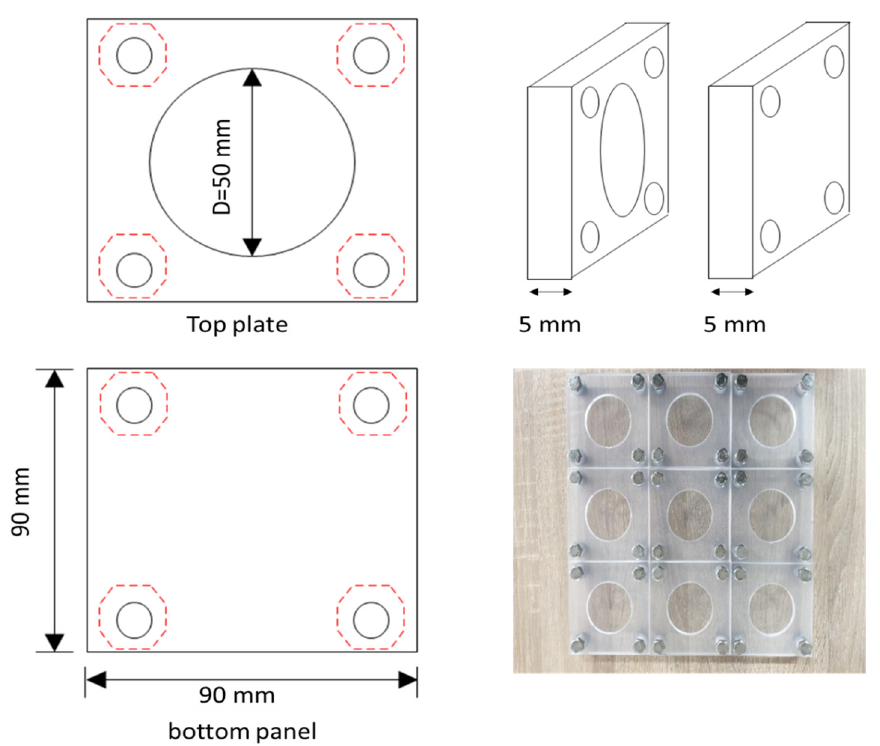
Figure 8. Water flow test specimens.